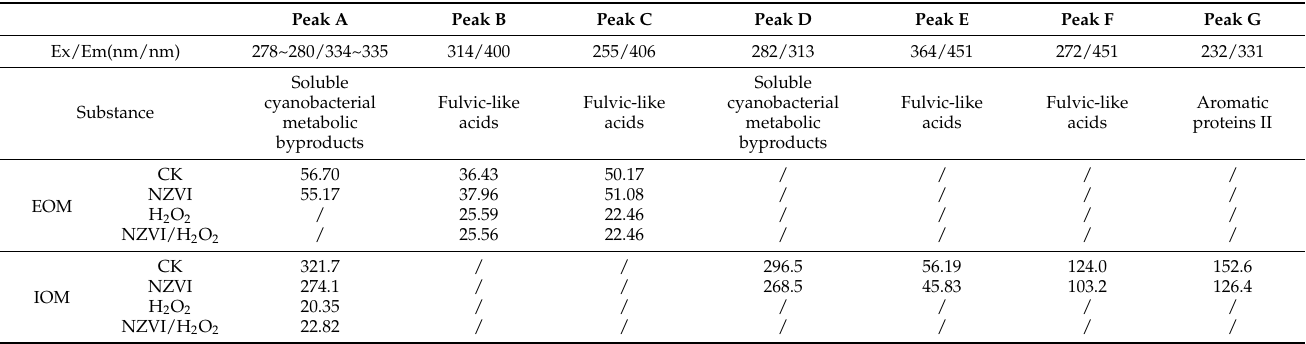
Table 1. Fluorescence intensities of EOM and IOM fractions after 5 days exposure to different